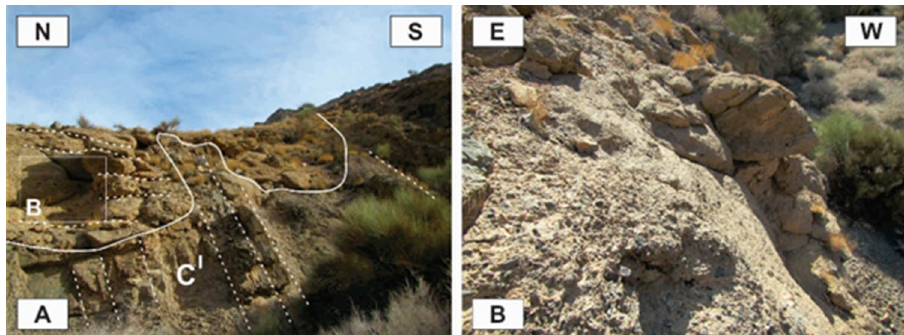
Figure 4. A horizontal conglomerate unit on the sub-vertical layers of the Carboniferous well-bedded limestones (C l ) in the southernmost part of Dareh-Nar valley. (Photos are taken by Mohammad Ali